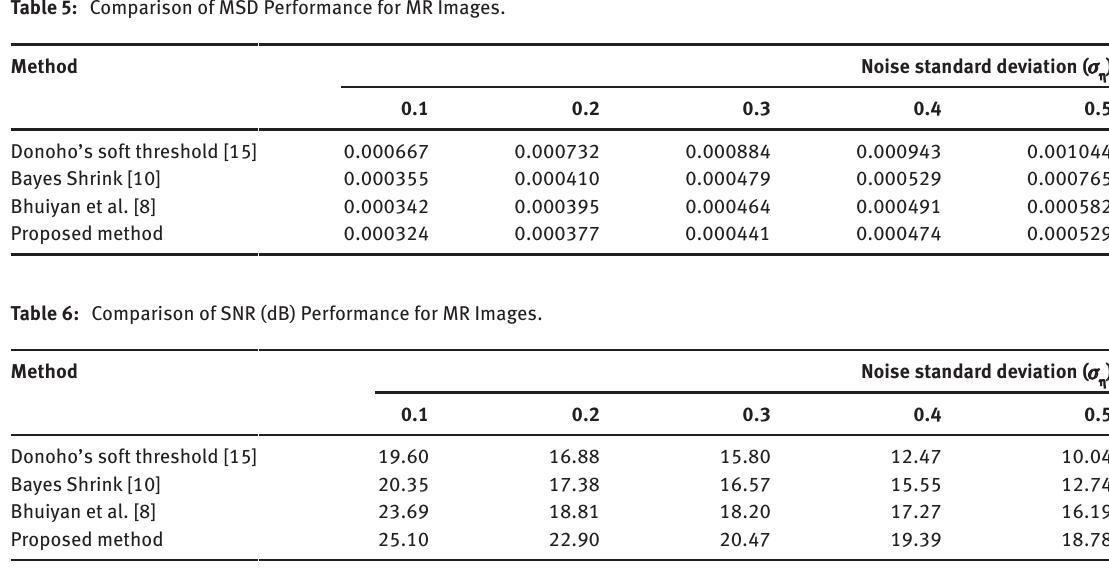
Table 5: Comparison of MSD Performance for MR Images.